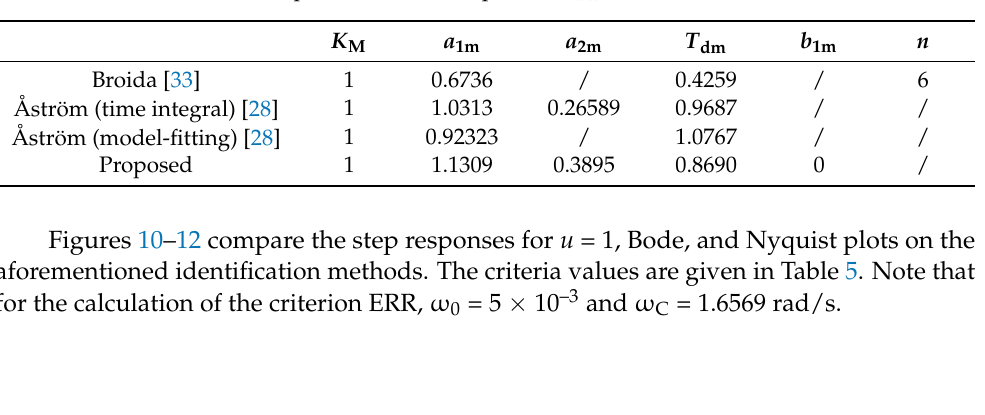
Table 4. The estimated model parameters for the process G P2